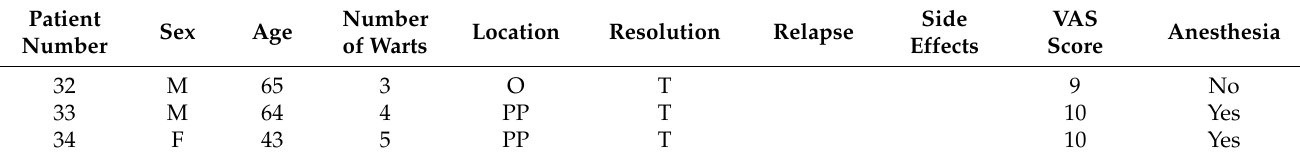
Figure 1. Patient n. 3 before treatment ( left ), during laser therapy ( central ), and 4 months after treat- ment ( right ).